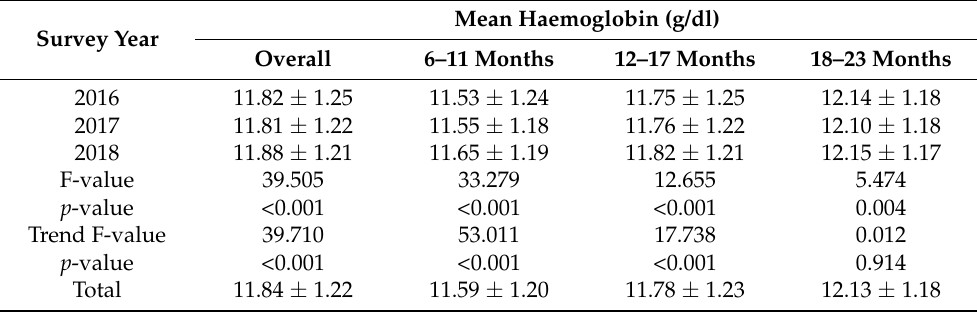
Table 3. Trends in haemoglobin concentration (mean ± SD) by age in 2016, 2017, and